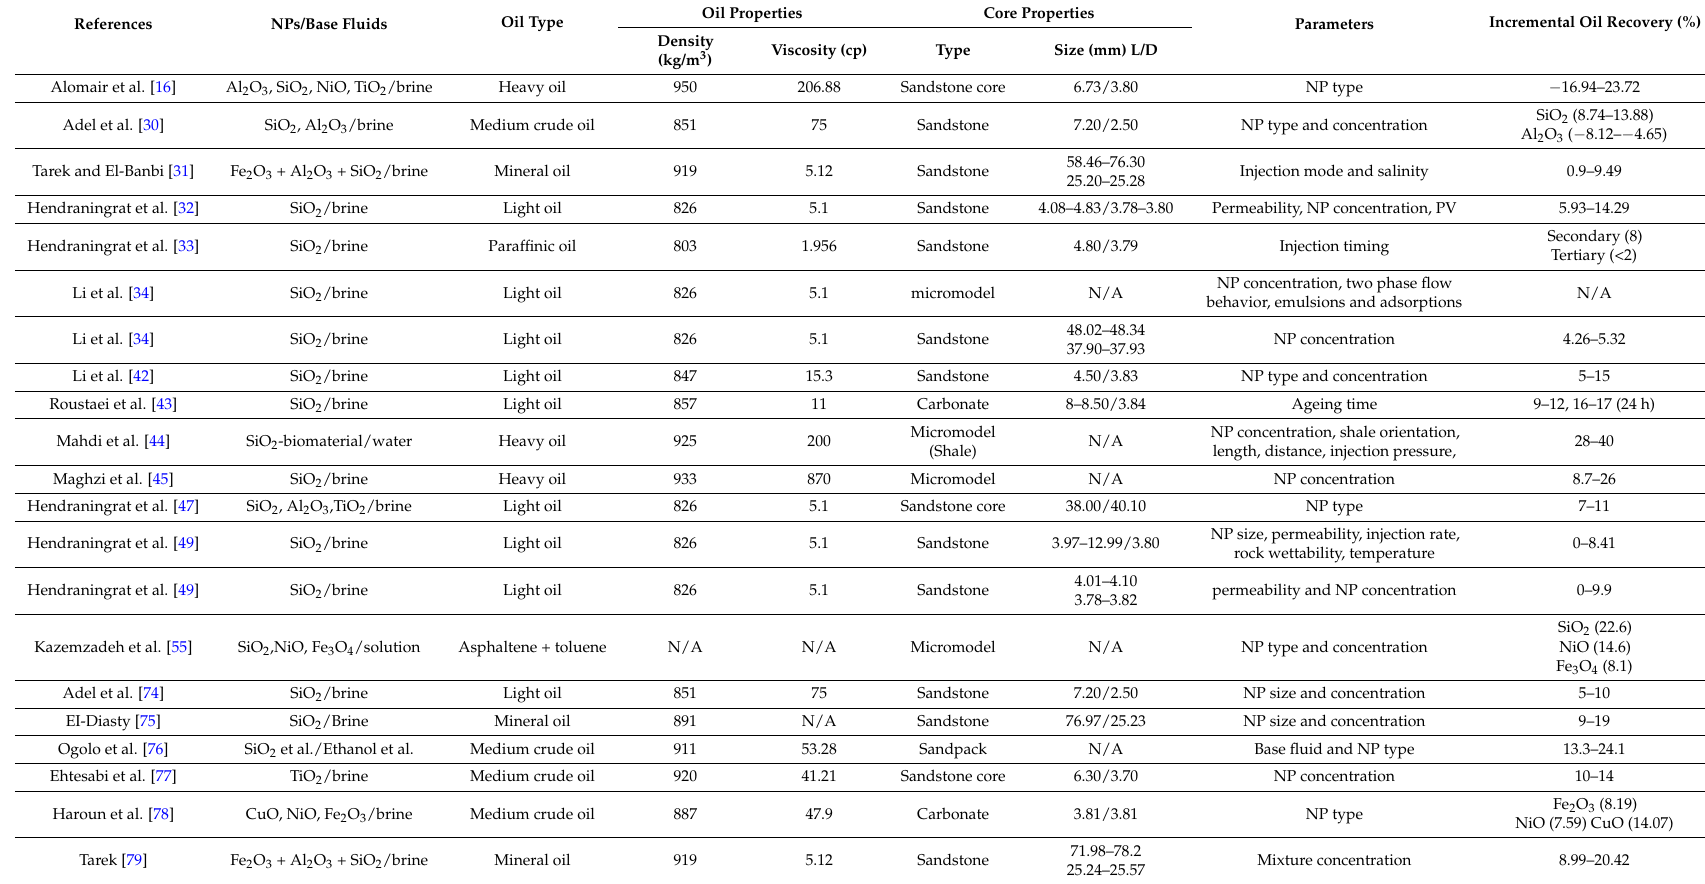
Table 2. Summary on the experiments for nanofluid